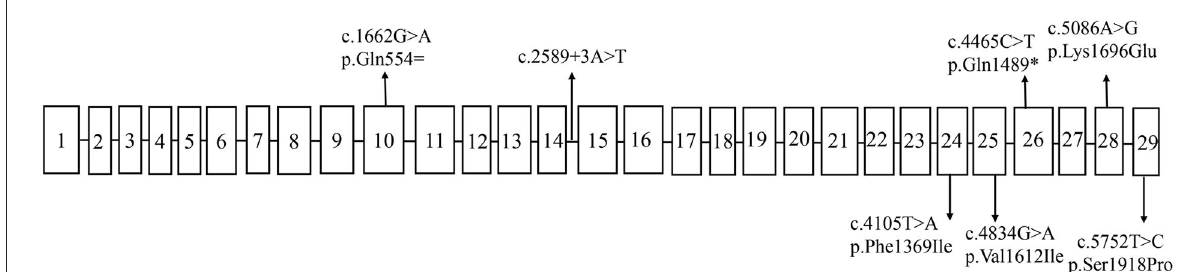
FIGURE2 The distribution of SCN1A variants sites.